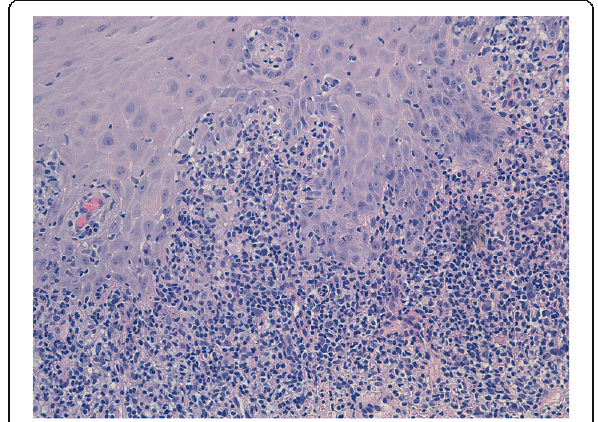
Fig. 4 Photobiomodulation therapy using a dual-wavelength diode